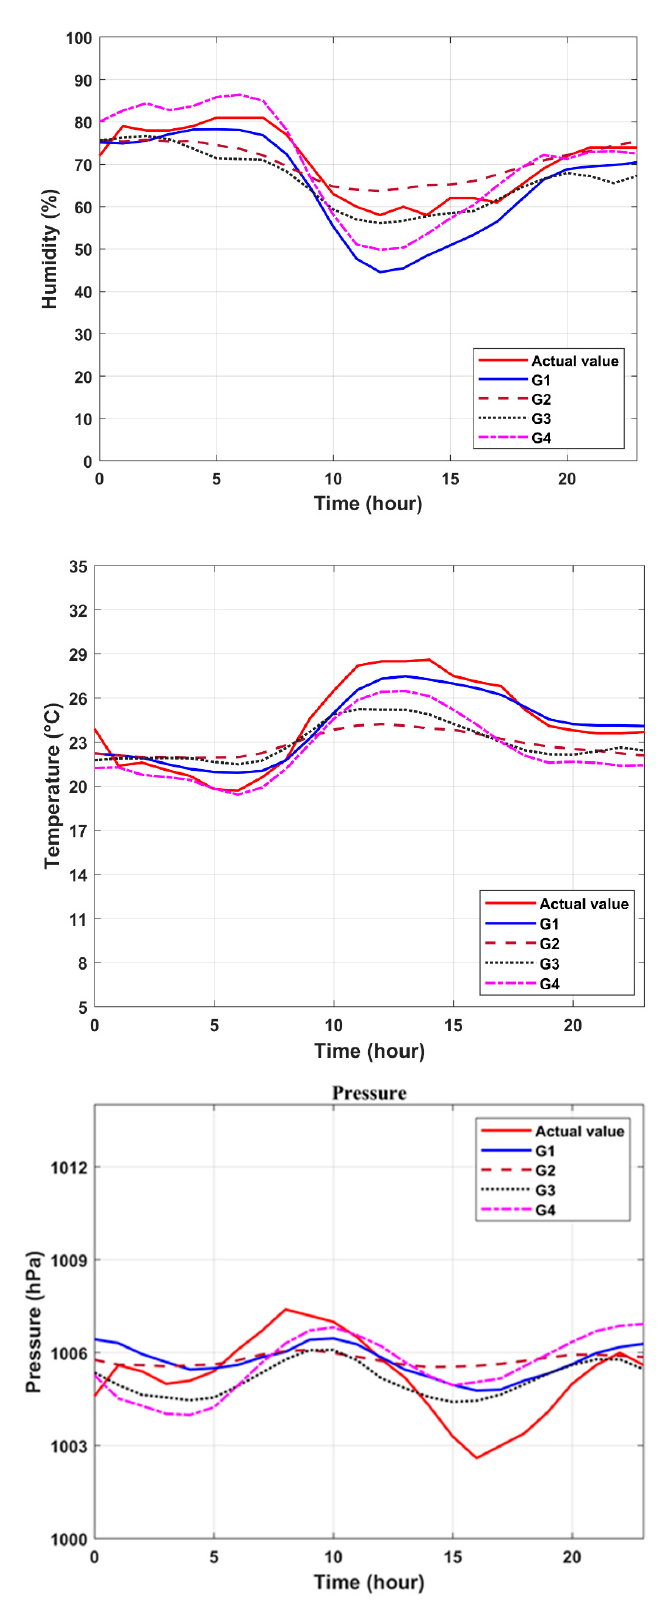
Figure 11. Forecast results of temperature, humidity, and pressure with the multilayer perceptron (MLP) model.